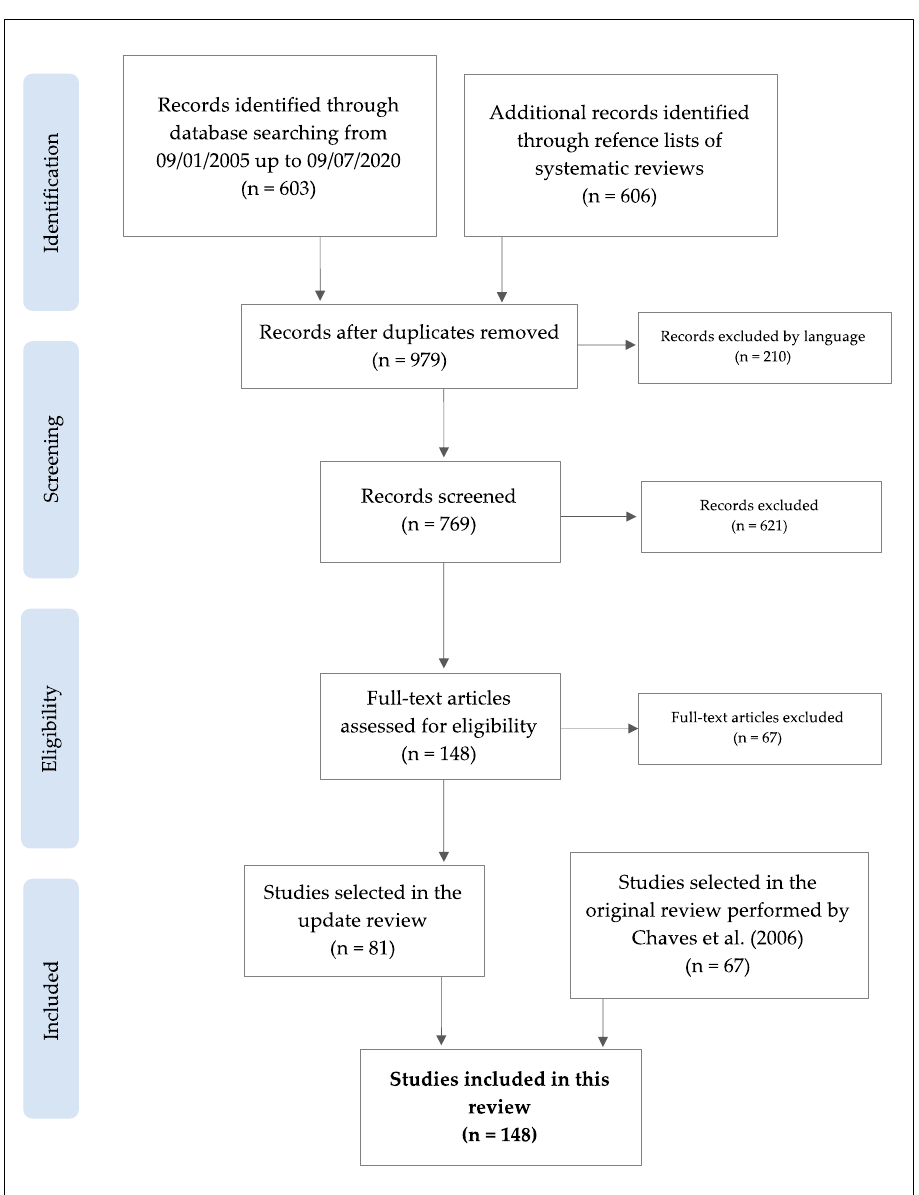
Figure 1. PRISMA flowchart. Figure 1. PRISMA Table 1. General characteristics of included studies.